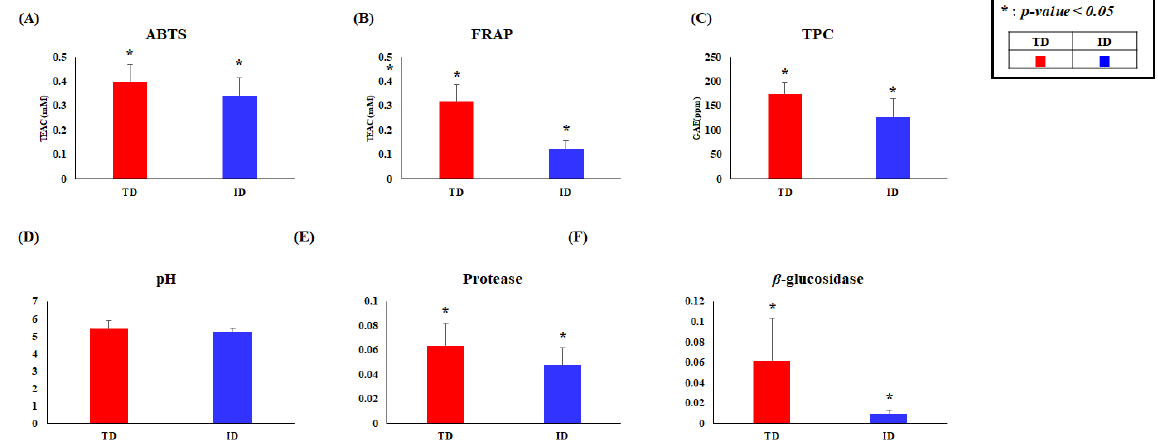
Figure 3. Antioxidant and enzyme activity analyses. ( A ) ABTS, ( B ) FRAP, ( C ) TPC, ( D ) pH, ( E ) protease and ( F ) β -glucosidase acitivities of traditional and industrial doenjang . The asterisks above the bars indicate significant difference, according to Levene’s test ( p < 0.05).